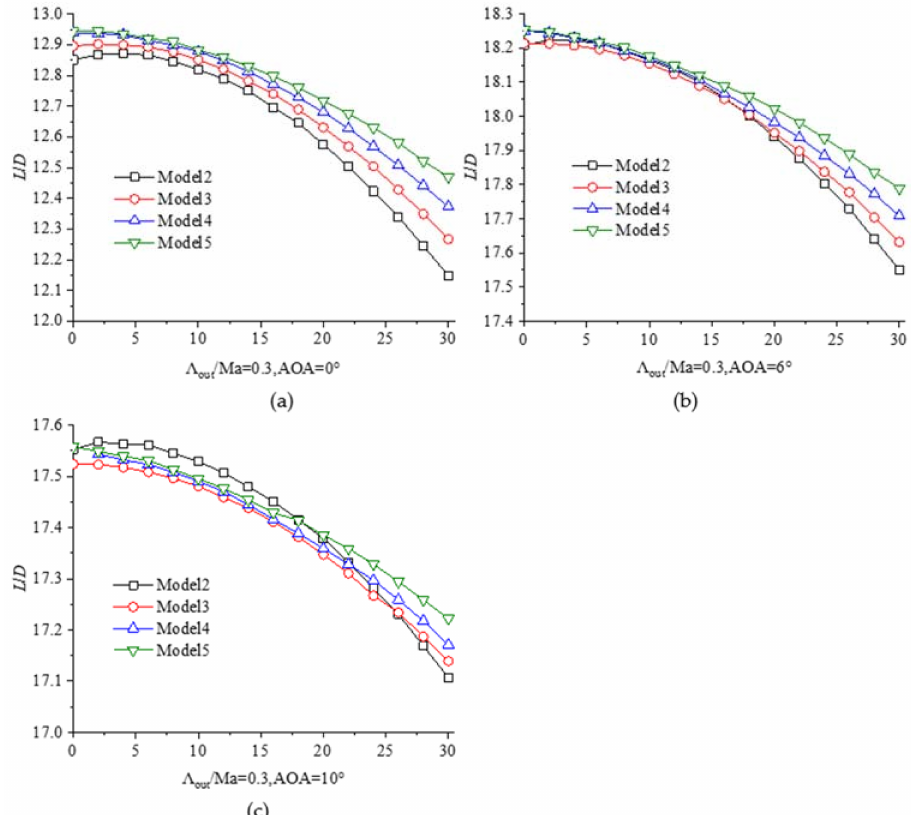
Figure 10. The change in the lift/drag ratio L / D of the pre-selected model under different angles of attack when Ma = 0.3. The angles of attack equals the following: ( a ) AOA = 0 ◦ , ( b ) AOA = 6 ◦ , ( c ) AOA = 10 ◦ ,